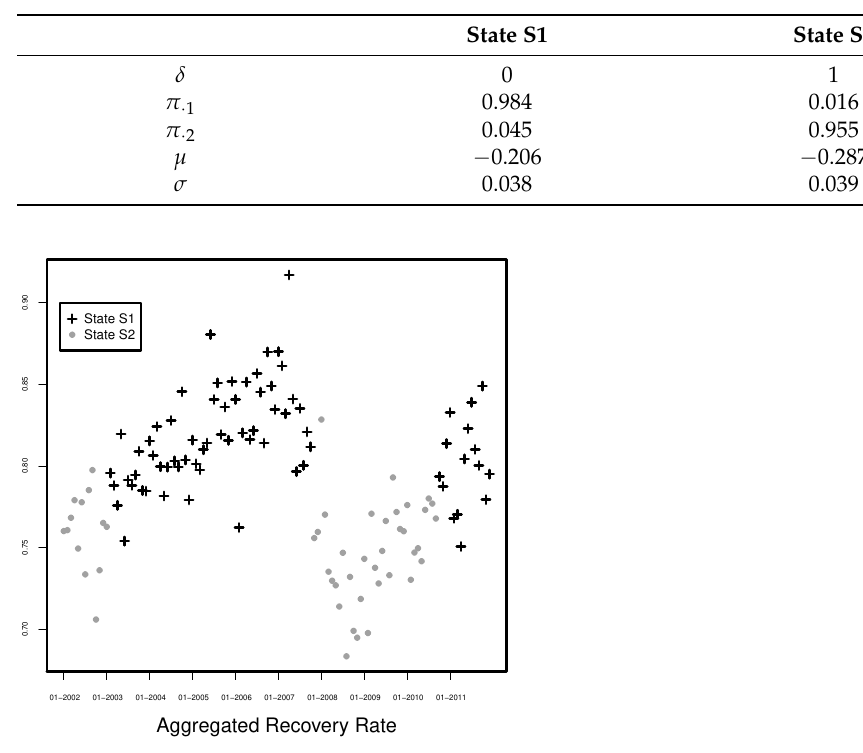
Table 7. Estimated parameters of the Markov switching model.